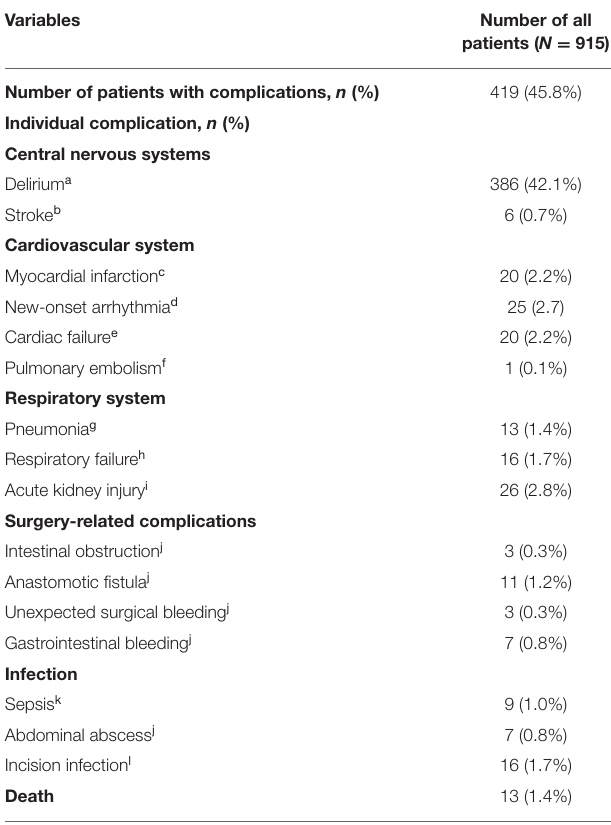
TABLE 1 | Frequency and definitions of major postoperative